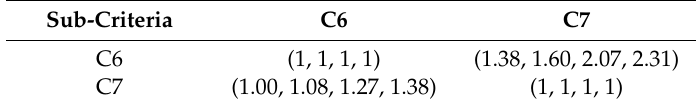
Table 10. Integrated fuzzy comparison matrix for Z3 sub-criteria weights.